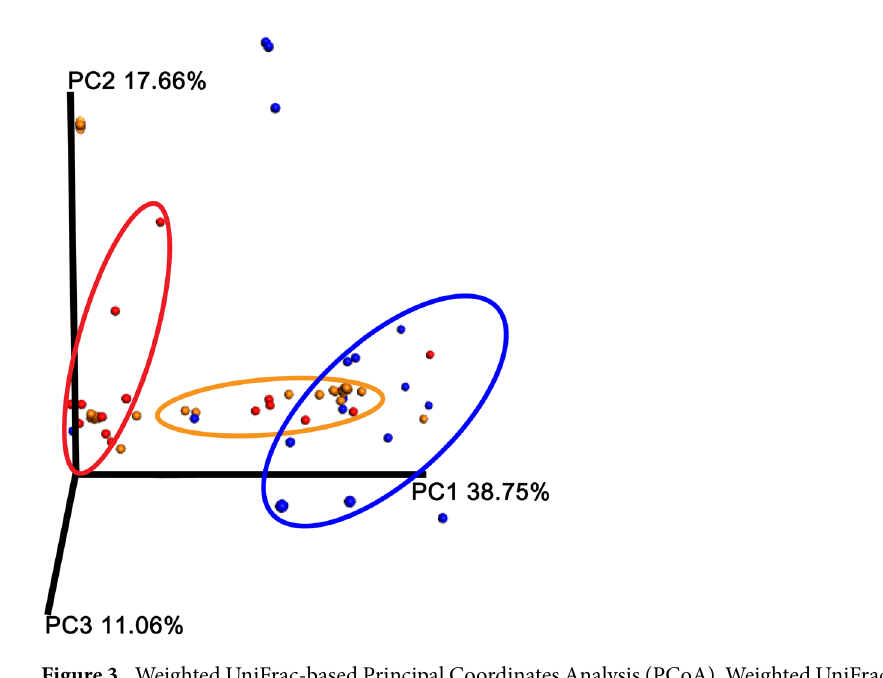
Figure 3. Weighted UniFrac-based Principal Coordinates Analysis (PCoA). Weighted UniFrac-based Principal Coordinates Analysis (PCoA) showing the clustering of bacterial communities according to the clinical grouping: Healthy (orange), Intermediate (red) and Vaginosis (blue). Each dot represents a sample. The Emperor PCoA plots were generated from the jackknifed_beta_diversity.py script of